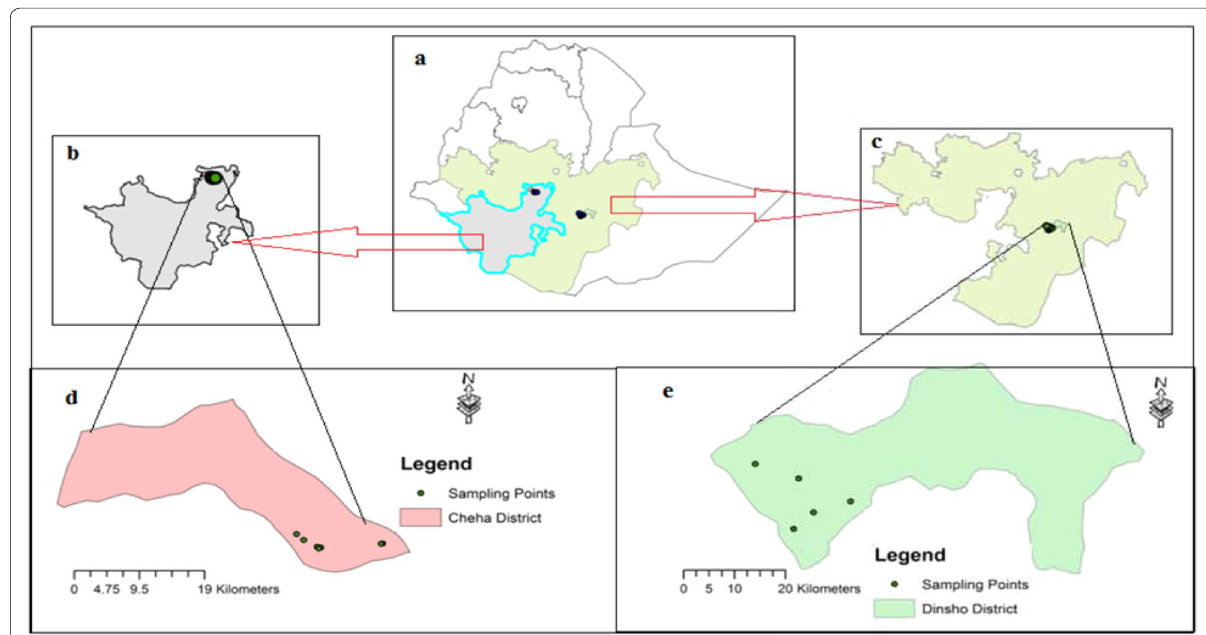
Fig. 1 Location Map of the Study Areas, a Oromia and SNNP regions in Ethiopia, b Cheha district in SNNP region, c Dinsho district in Oromia region, d Cheha district, e Dinsho district